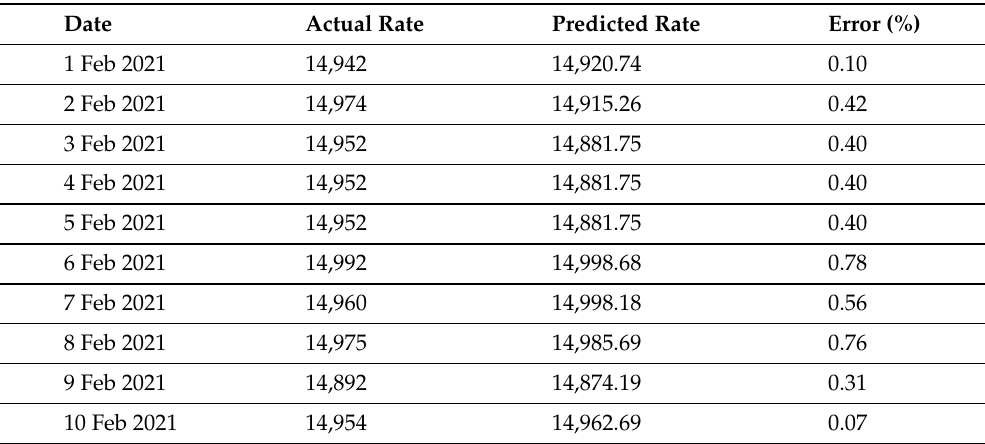
Table 6. Prediction results of ten-day exchange rate changes.